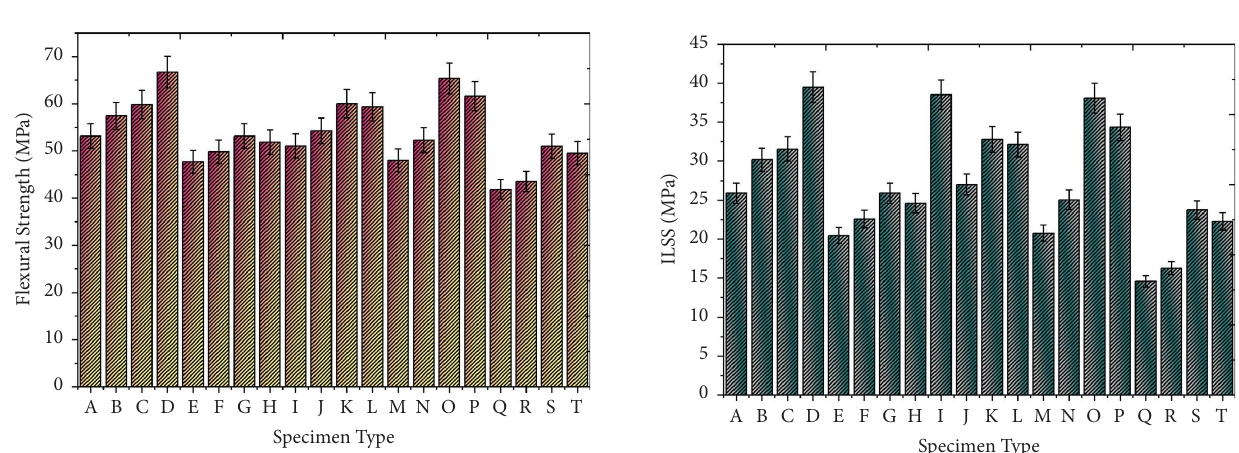
2 O 3 /jute/hemp/ep-